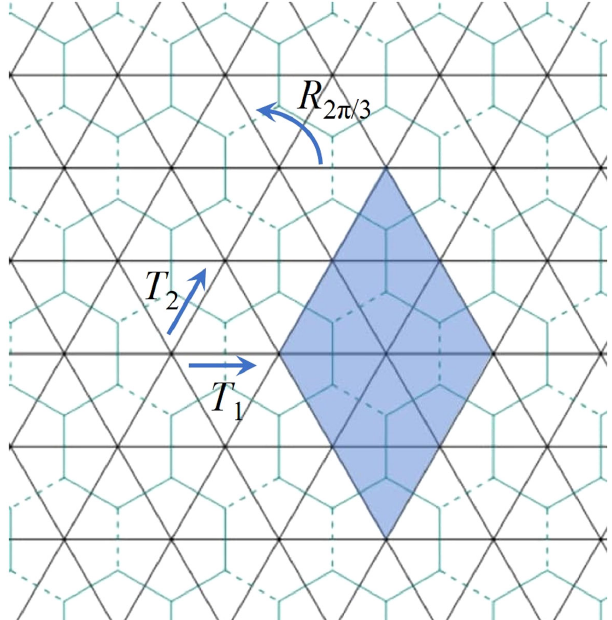
FIG. 1. The triangular moir´e lattice, and its dual honeycomb lattice. In the parton construction II, the bosonic parton b α is at half filling for each spin-valley flavor, which becomes a π flux of the dual gauge field A μ through the hexagon of the dual honeycomb lattice. Hence the vortex ψ defined on the dual honeycomb lattice does not have a uniform hopping amplitude; the dashed links on the dual honeycomb lattice have negative hopping amplitudes. The symmetry of the lattice will be realized as a projective symmetry group. There are eight dual sites per unit cell (shaded area) in this gauge choice. At each spin-valley flavor, there are translation symmetries T 1 , a rotation symmetry R 2 π , ; 2 = 3 x → − x Þ and time reversal T . We and a product of reflection P x ð also argue that P is a symmetry of the system as long as there is y no valley mixing, and the sixfold rotation R π becomes a good = 3 approximate symmetry of the Hubbard model in the case of long moir´e lattice